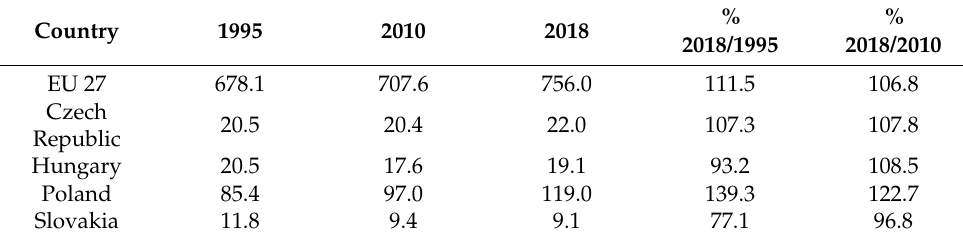
Table 2. The number of buses and coaches in use in the V4 countries and the EU in 1995–2018.